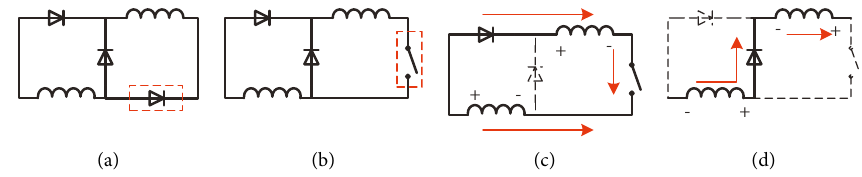
Figure 1: Switching-inductor units and operating conditions. (a) Switching-inductor [16]. (b) Improved switching-inductor. (c) The operating condition when the switch is turned on. (d) The operating condition when the switch is turned off.